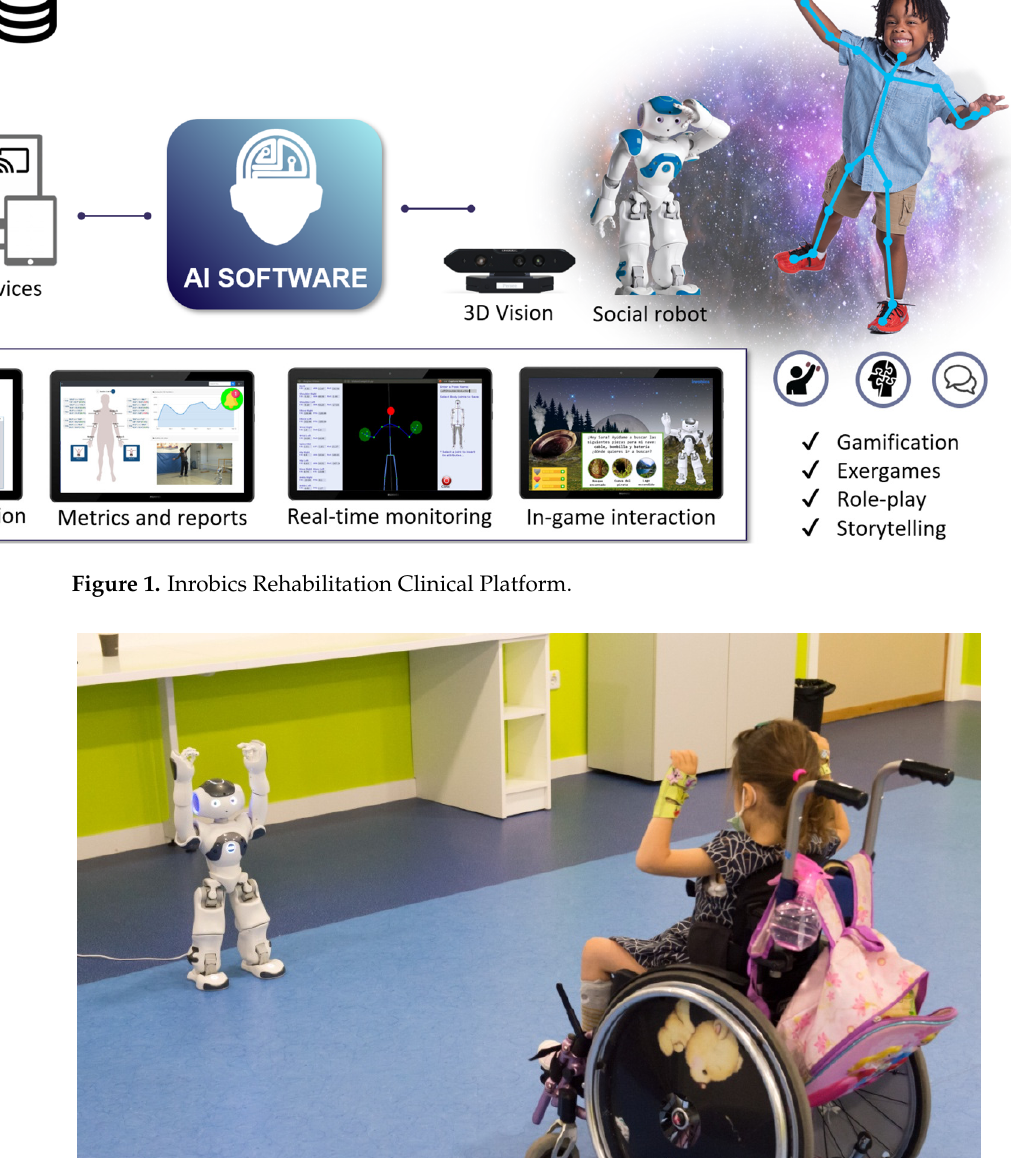
Figure 1. Inrobics Rehabilitation Clinical Platform.